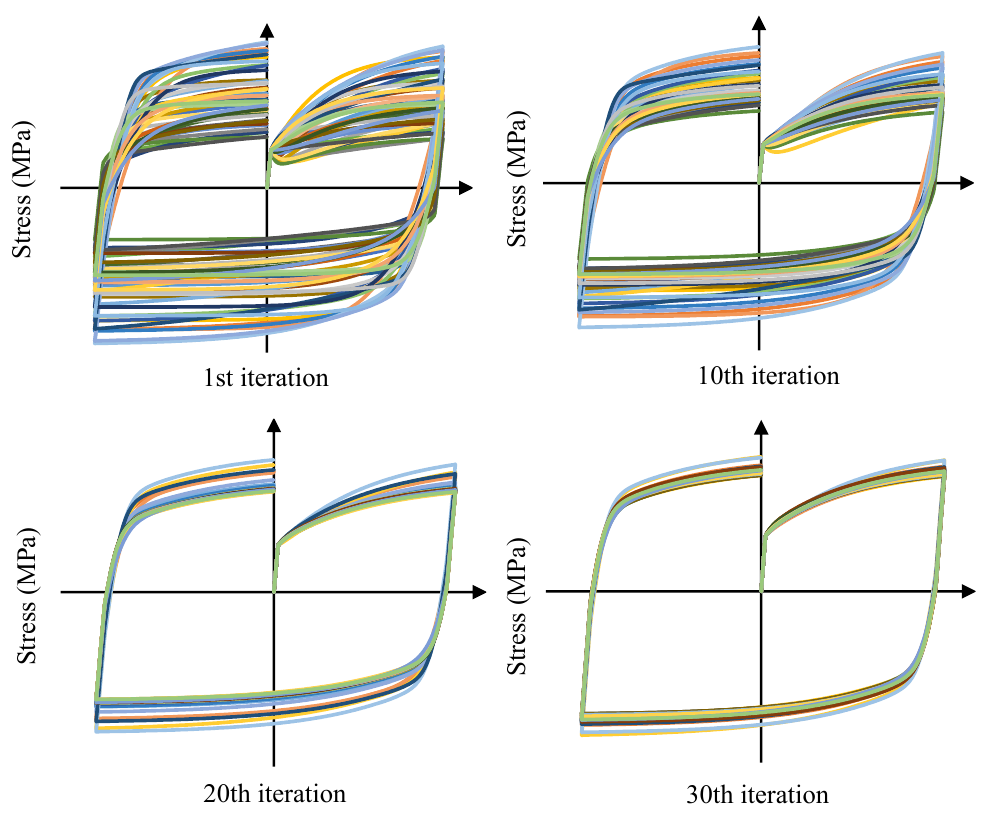
Figure 5. Stress-strain response curve iteration with standard PSO.